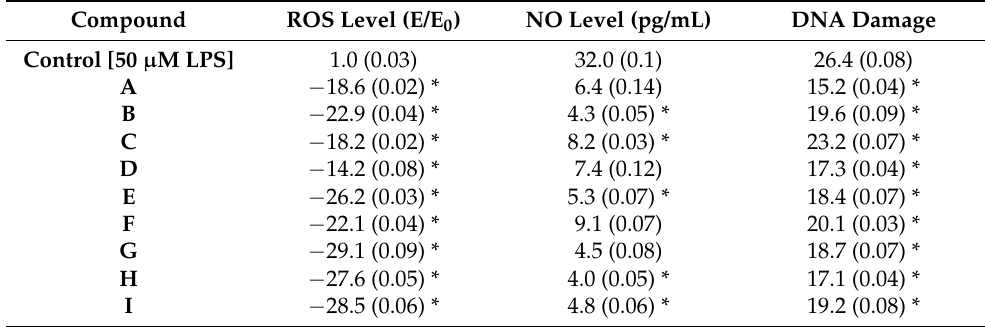
Table 3. ROS and RNS scavenging activity of tested compounds and an impact on the reduction of DNA damage ((SD) n = 6); the results were compared to the control and expressed as E/E 0 ratios for ROS; concentration [pg/mL] for NO and the ratio of cell nucleus diameter to halo diameter for DNA damage; statistical significance calculated with post-hoc test compared to control (* p < 0.05; E 0 —cultures without tested